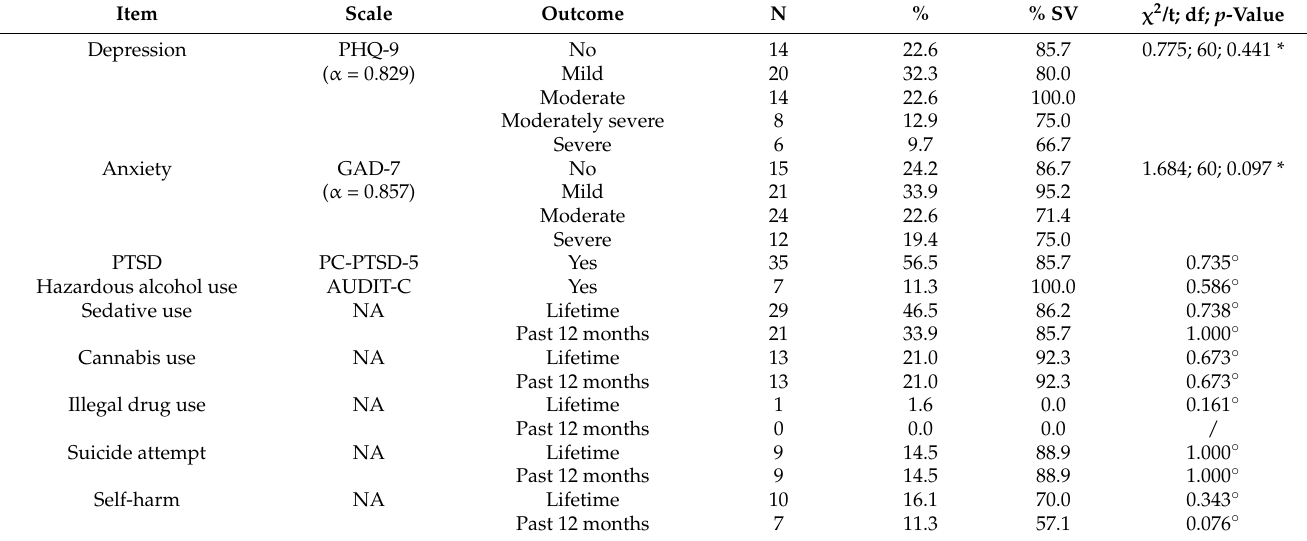
Table 6. Descriptive statistics of mental health status and sexual victimization ( n =